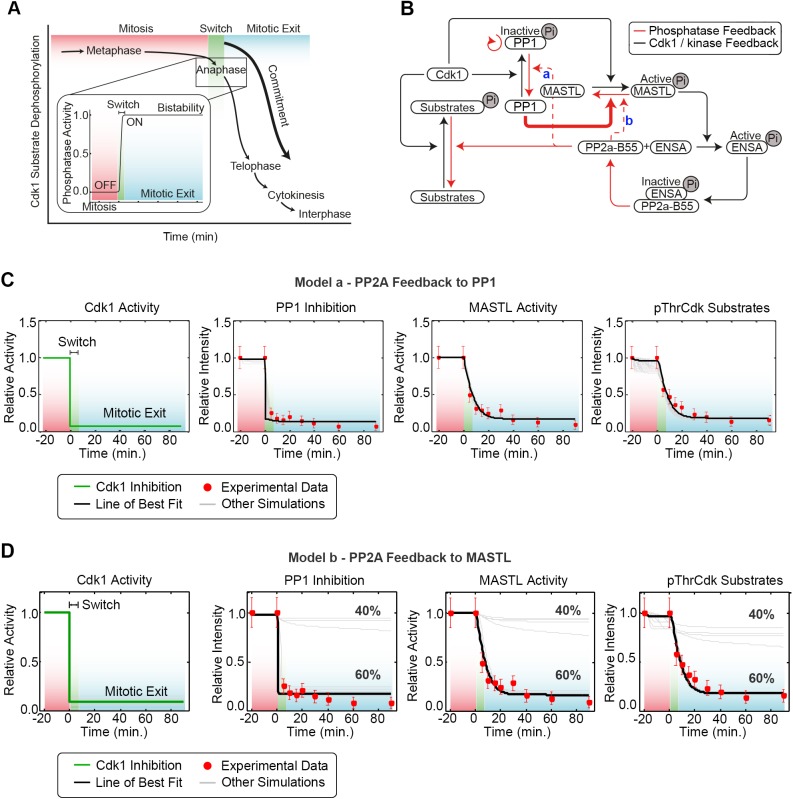
The bistability of mitotic exit can be modelled using observed experimental parameters. (A) A model of the bistable phosphatase activity during mitosis, with repression (red shading) during metaphase and activation (blue shading) separated by the bistable switch (green shading). (B) Schematic of the mathematical model, with dephosphorylation of MASTL by PP1 (bold red line) and feedback from PP2A (dotted red line) onto either PP1 (a; model a) or MASTL (b; model b). (C,D) Optimized mathematical model where model a is fitted to training data from 50 independent parameter estimation runs (C). Best fit (black line) depicts 91.1% Cdk1 inhibition. (D) Model b – 60% of the simulations run accurately fit experimental data.